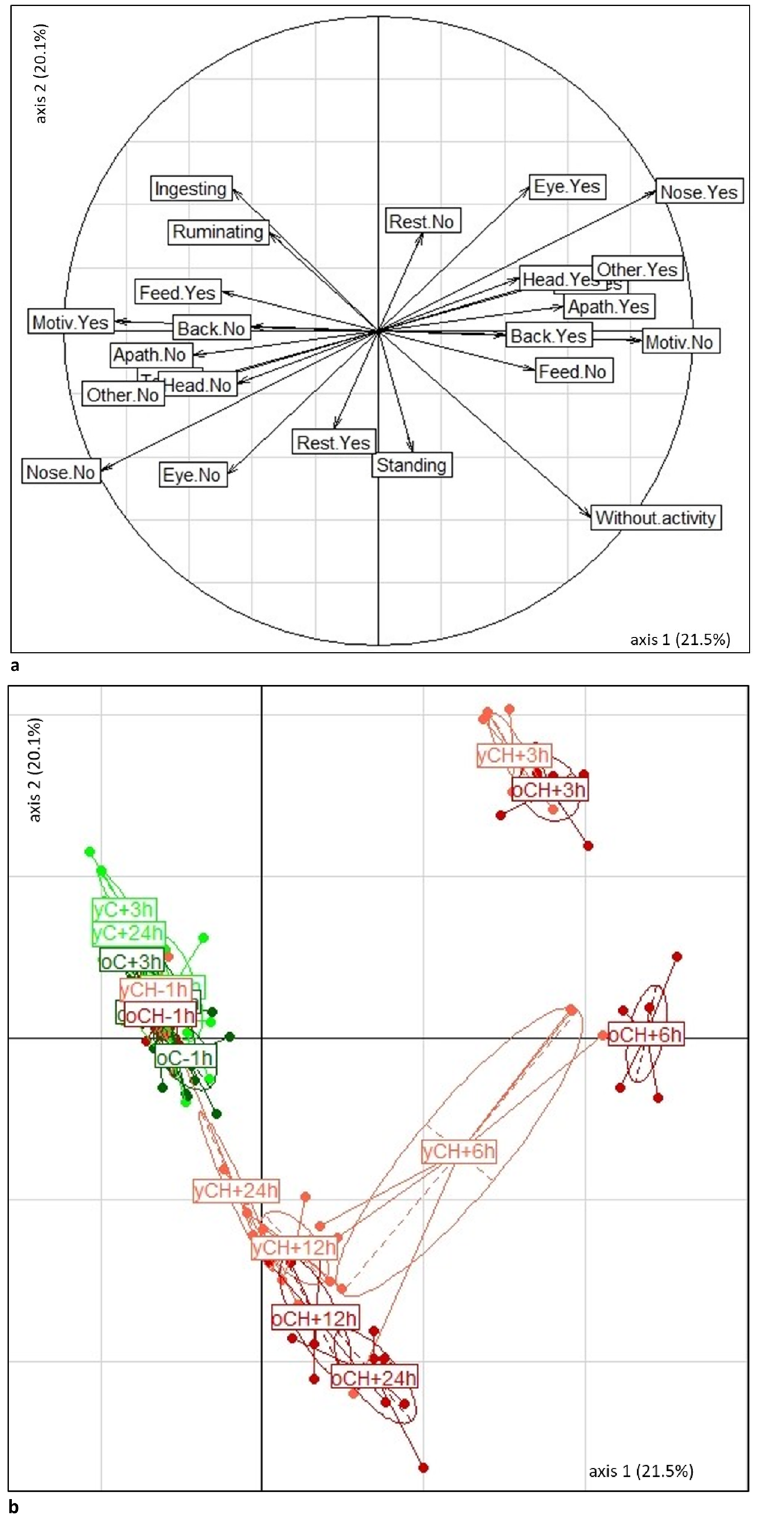
Figure 9. Factorial map of the discriminant analysis on behavioural signs in 6 old and 6 young Holstein cows under LPS CHALLENGE and CONTROL situation at T−1 h, T + 3 h, T + 6 h, T + 12 h and T + 24 h after intravenous injection of LPS (0.5 µg/kg of BW) (or equivalent time in the CONTROL situation): loadings of ( a ) the variables and ( b ) the individuals on axis 1 and axis 2 of the factorial discriminant analysis. Due to plot size limitations, the label tags have been simplified on the plot: “oCH + 3 h” corresponds to old cows in the CHALLENGE situation at 3 h after injection, “yC + 3 h” corresponds to young cows in the CONTROL situation at 3 h after T0, and so on. See Table 4 for details of the names of the variables and all variable-to component